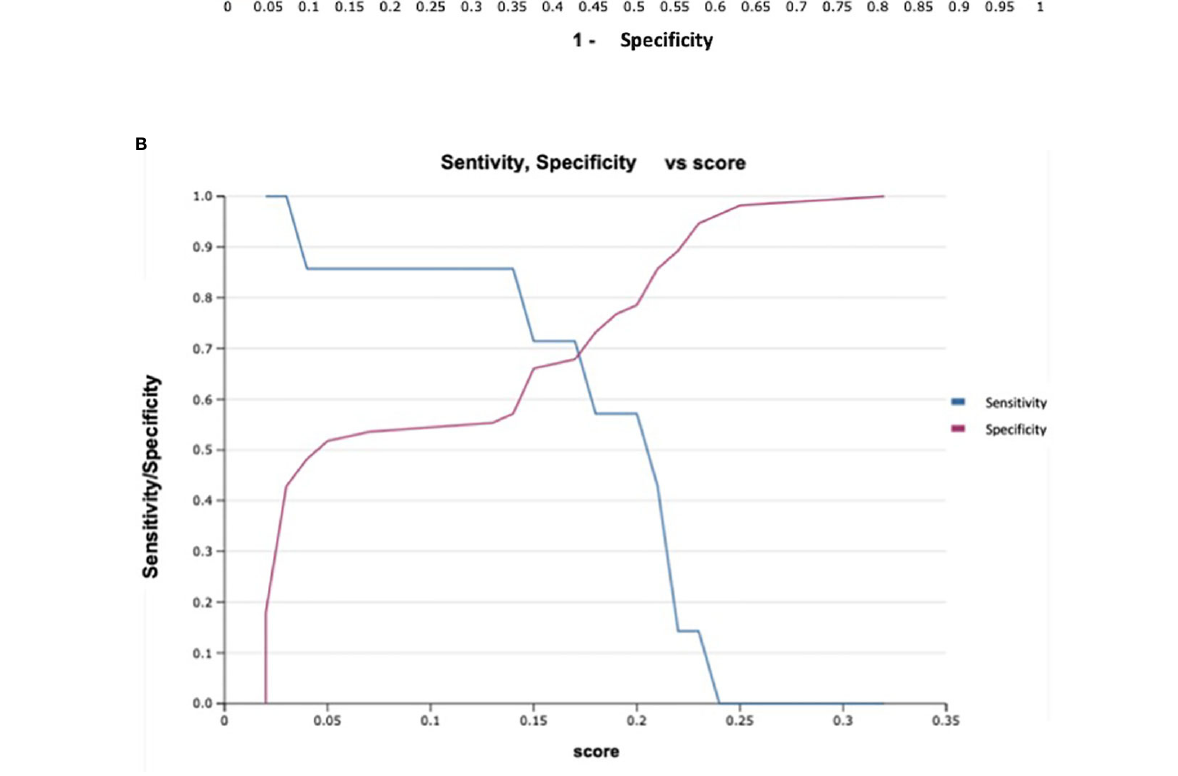
FIGURE 6 Sensitivity and Speci fi city of CER-CAP score: (A) . ROC Curve, ROC, Receiver Operating Characteristic; AUC, area under the curve. (B) . Sensitivity/Speci fi city vs